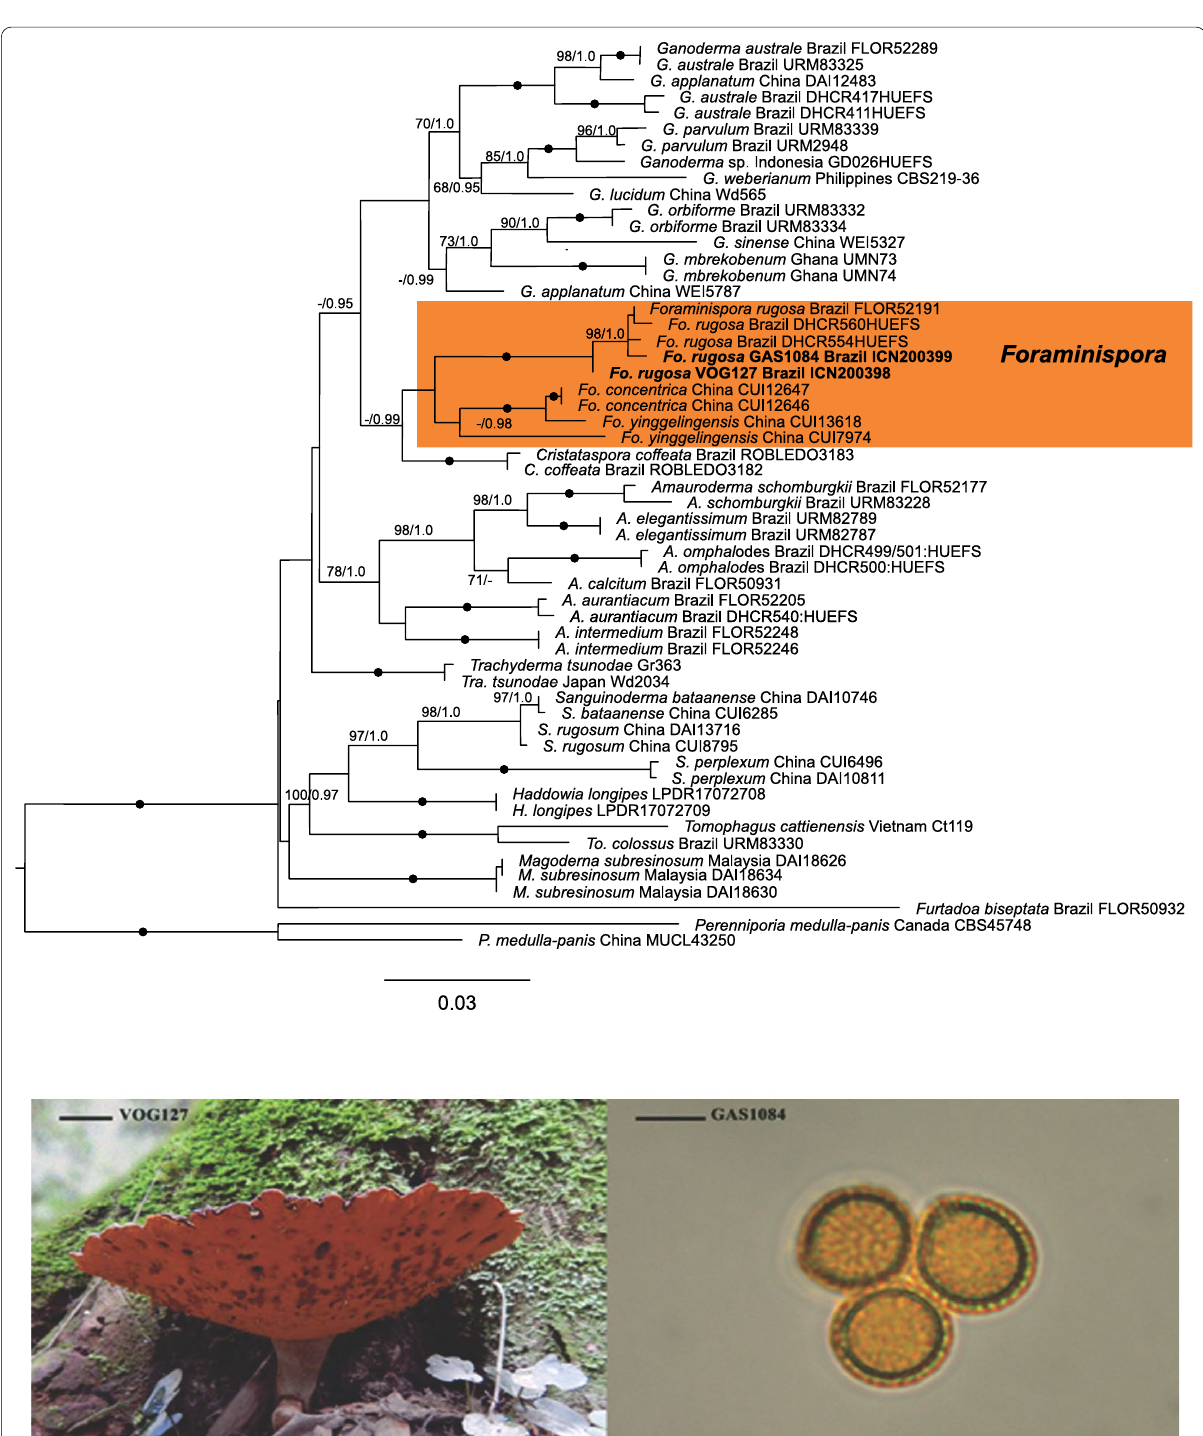
Fig. 1 The sequences of ITS and 28S of the samples VOG127 and